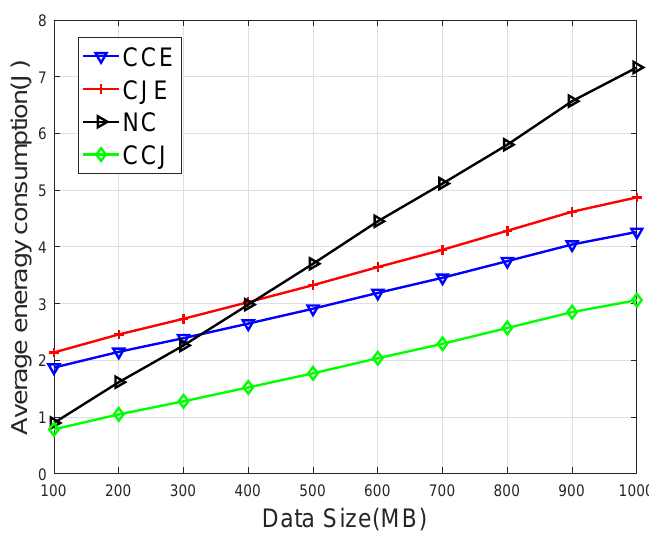
Figure 6. Average energy consumption on the four schemes versus the data size d k .